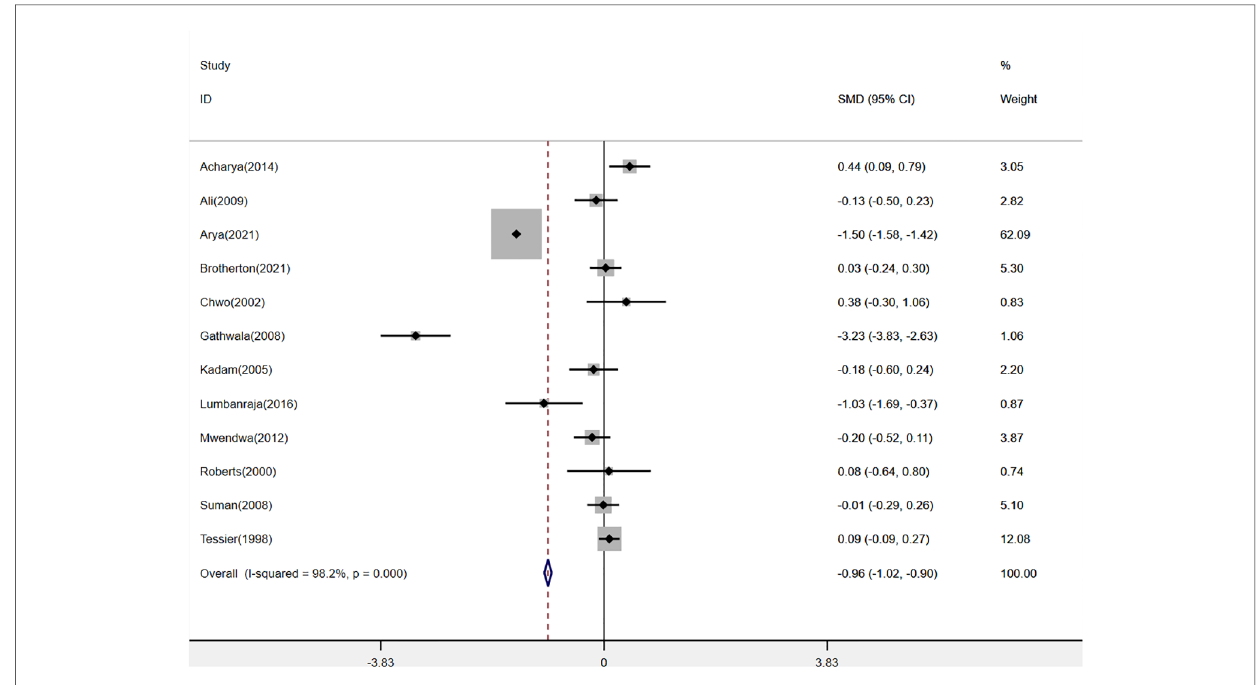
FIGURE 3 Forest plot of the mean duration of hospital stay for KMC versus control group.